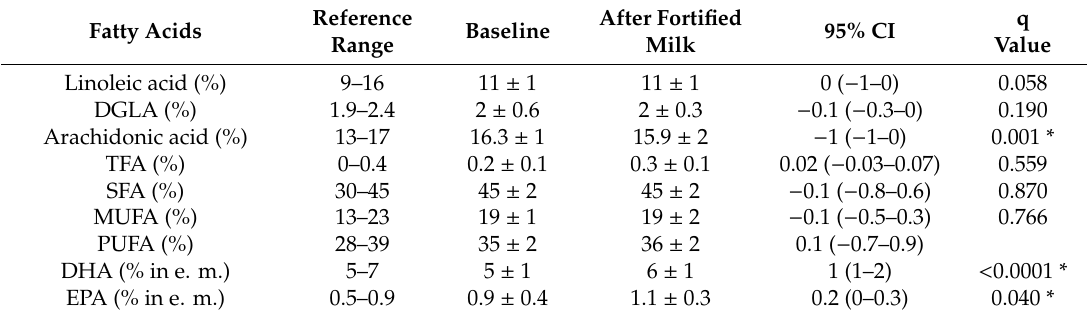
Table 6. Measurement of fatty acid profile in erythrocyte membranes at baseline and after treatment. Fatty Acids